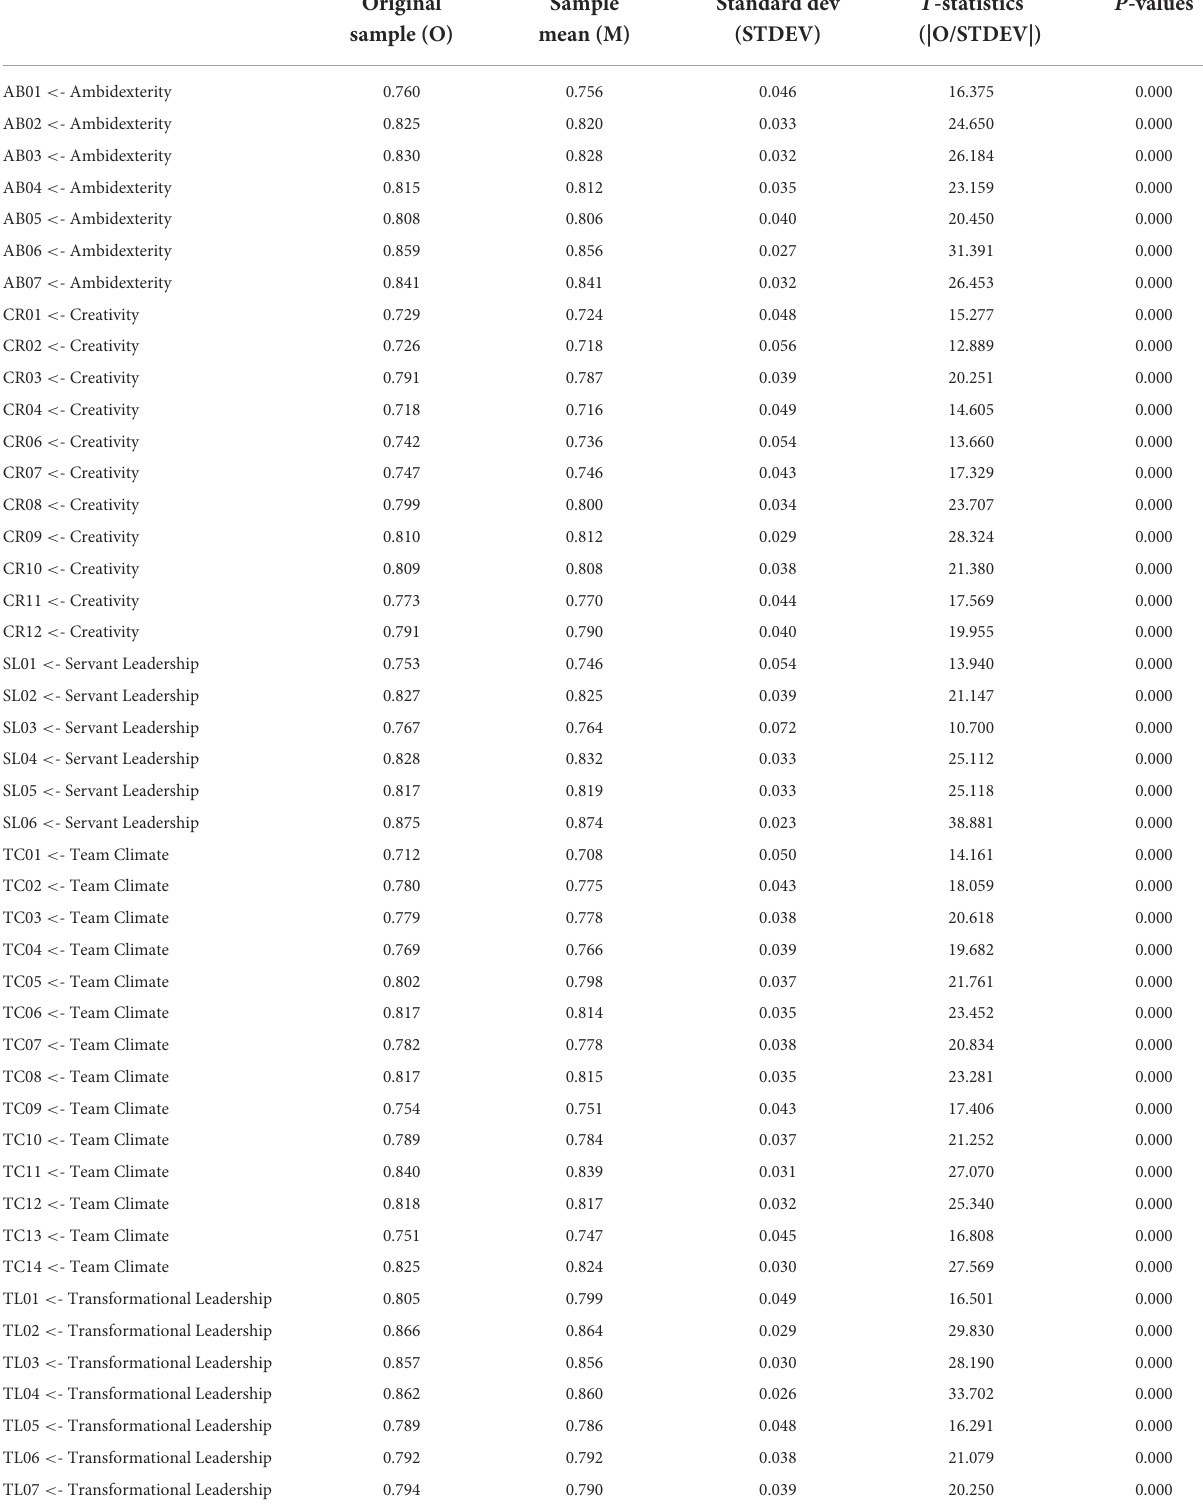
TABLE 7 Outer loading and t